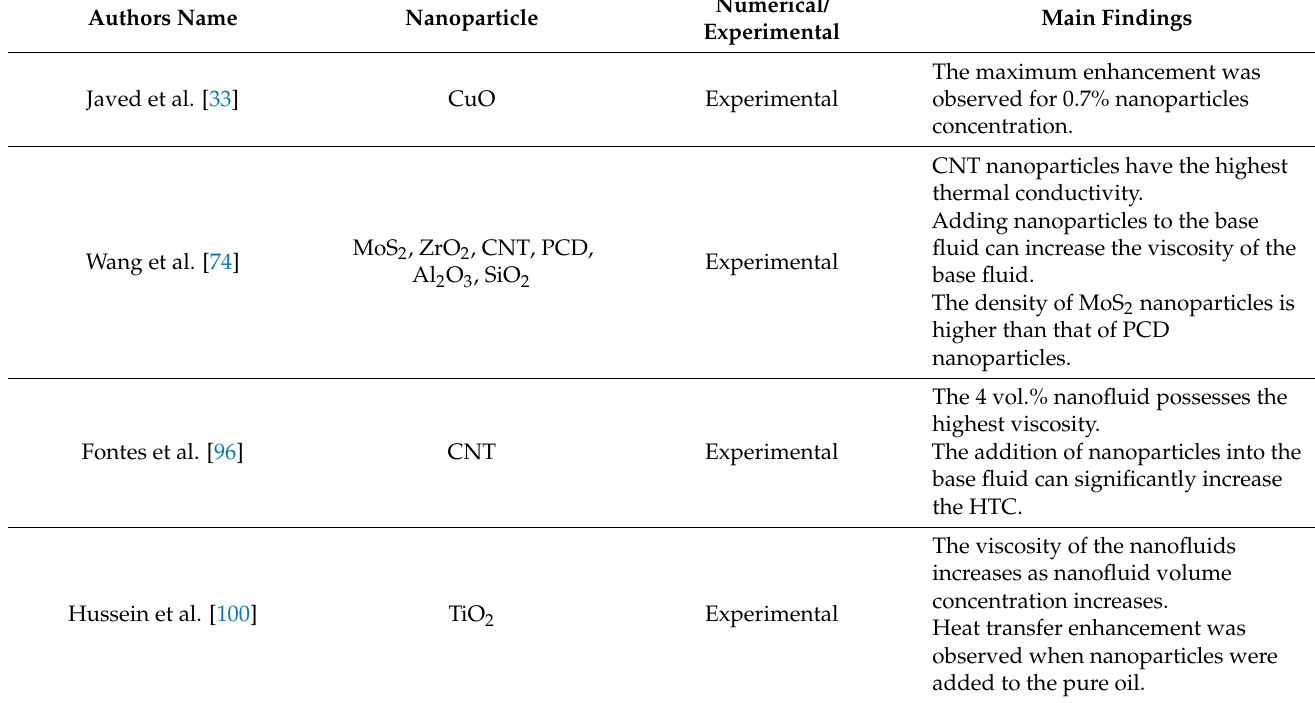
Table 10. Comparison of previous investigations on palm-oil-based